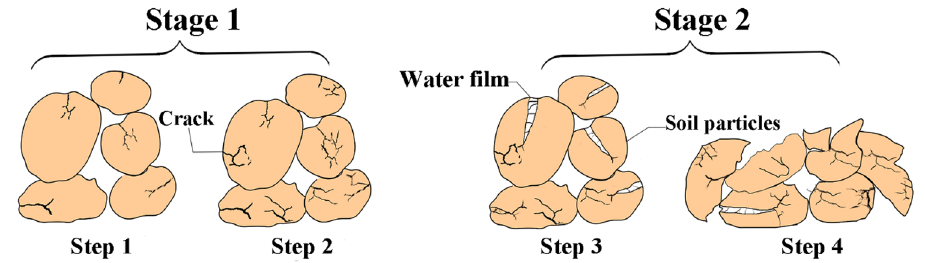
Figure 10. Schematic diagram of the soil weathering process during freeze–thaw